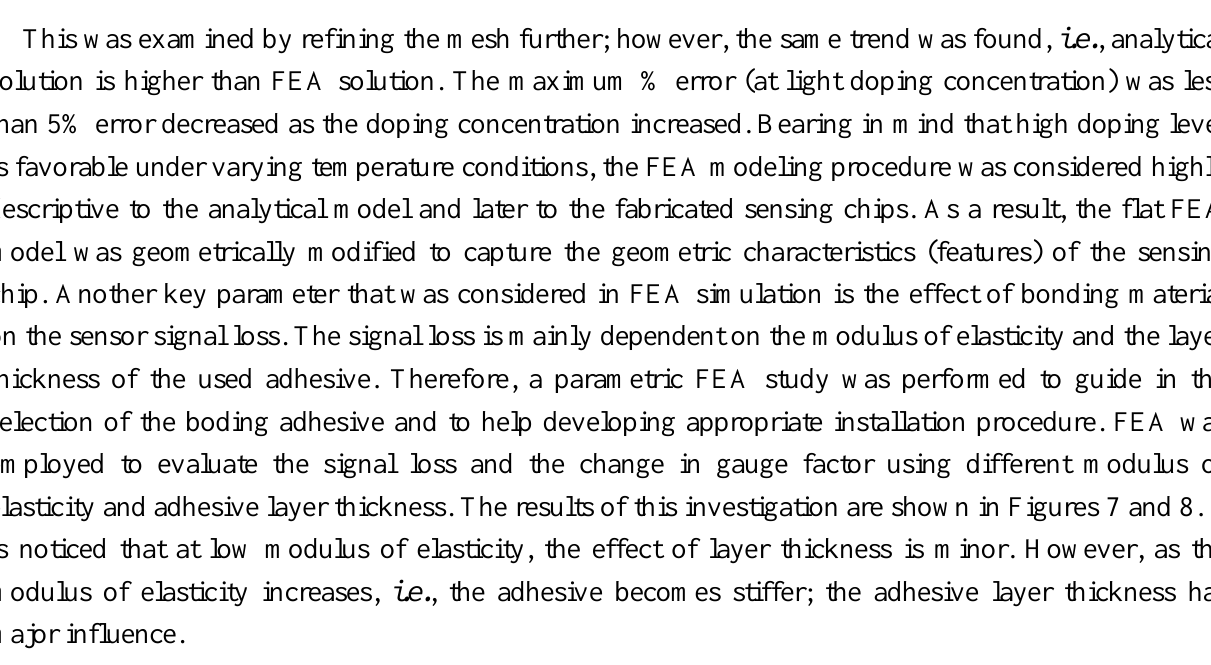
) on the sensor b